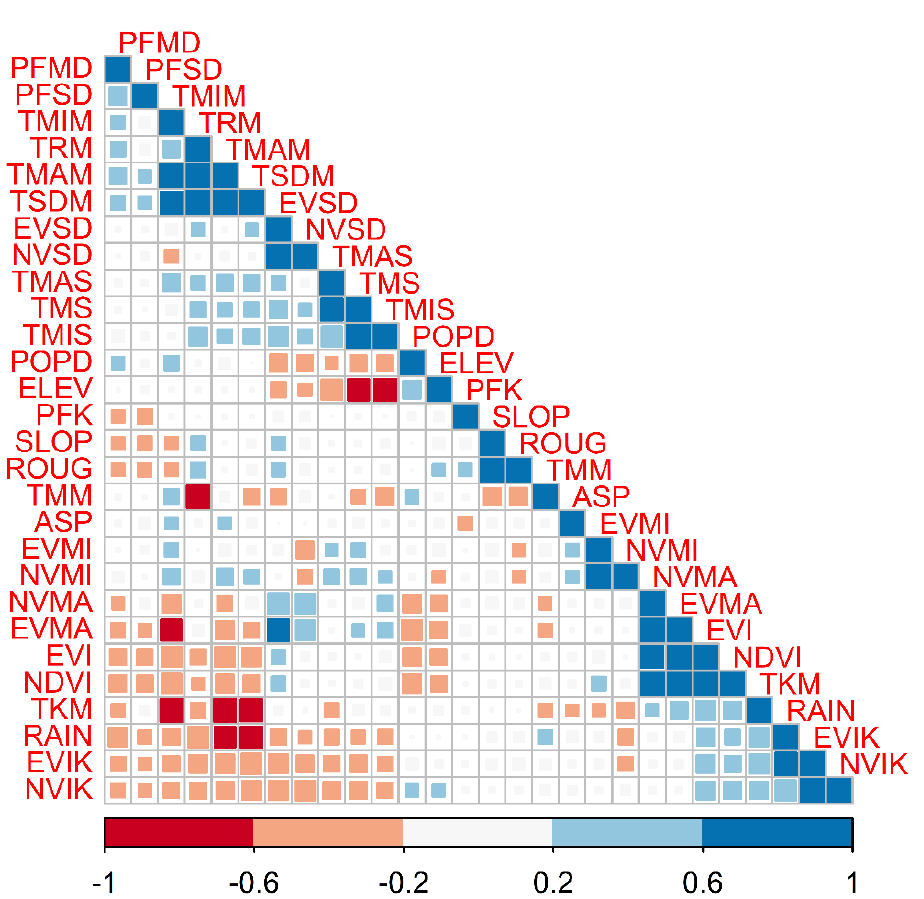
Figure 4. Pairwise Pearson’s correlation between environmental variables at the occurrence points for Anopheles albimanus in Costa Rica. Correlations have been clustered to ease the visualization of groups of highly correlated variables.